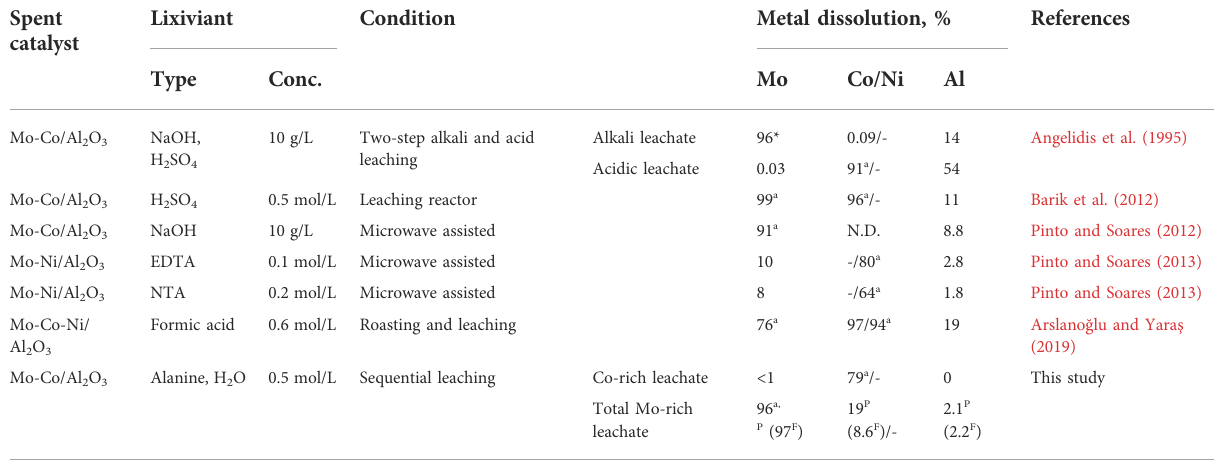
TABLE 3 Comparison of the spent hydrodesulfurization catalyst leaching